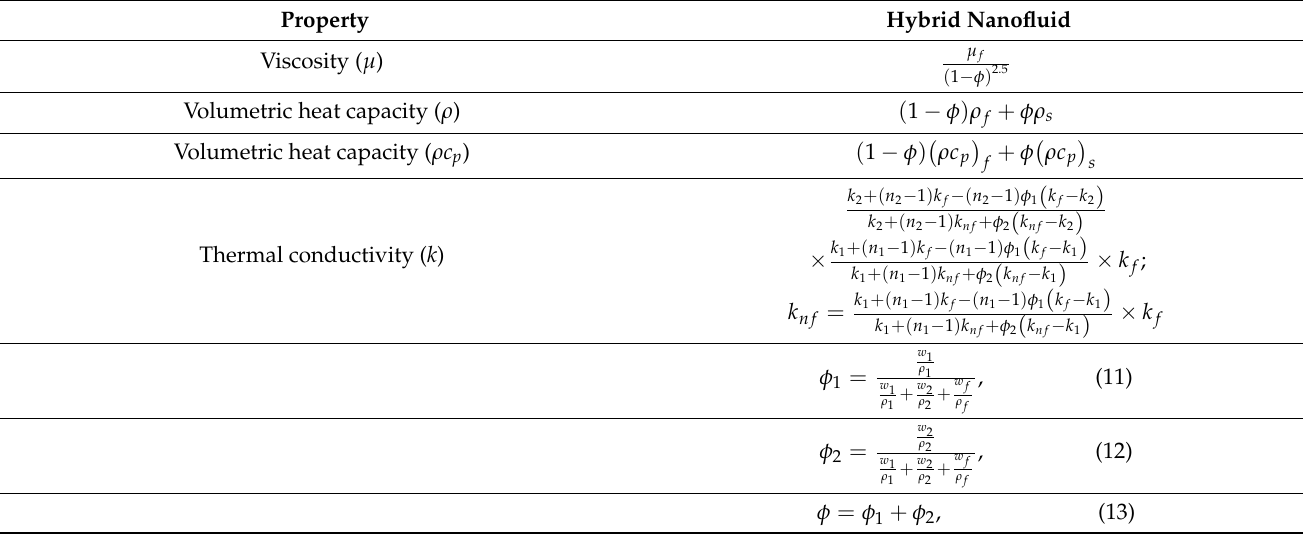
Figure 3. The effect of